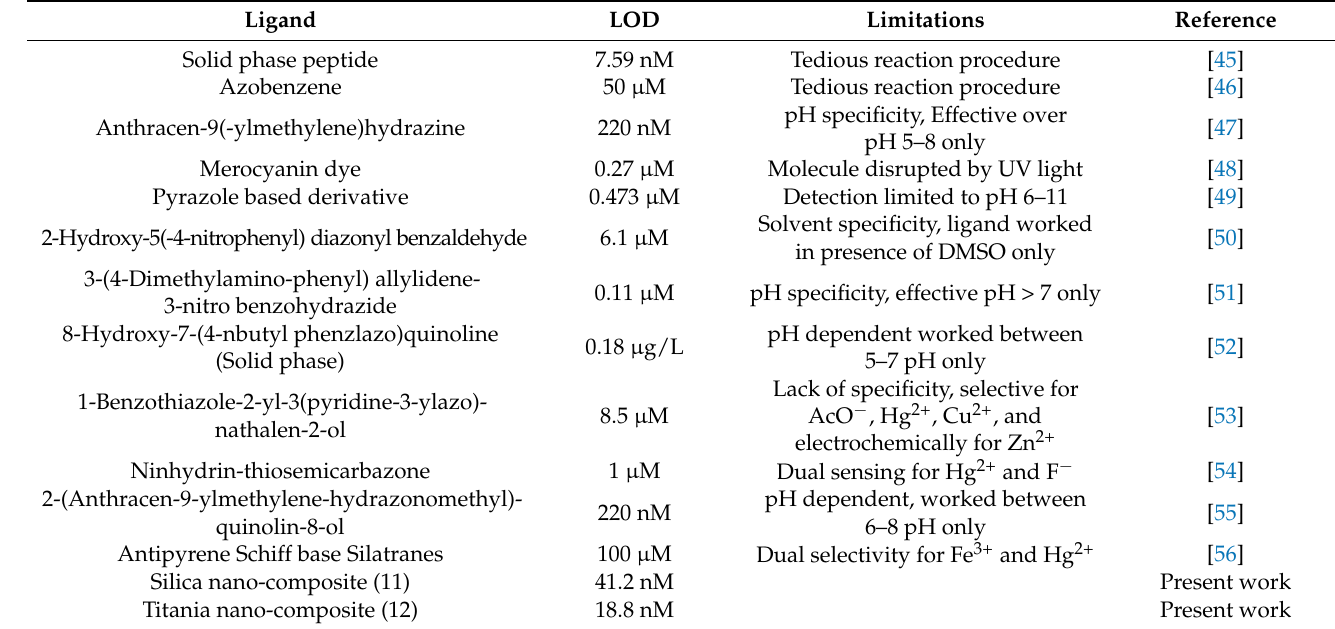
Table 1. Comparative examples of some of recently reported sensors of Hg 2+ ions.